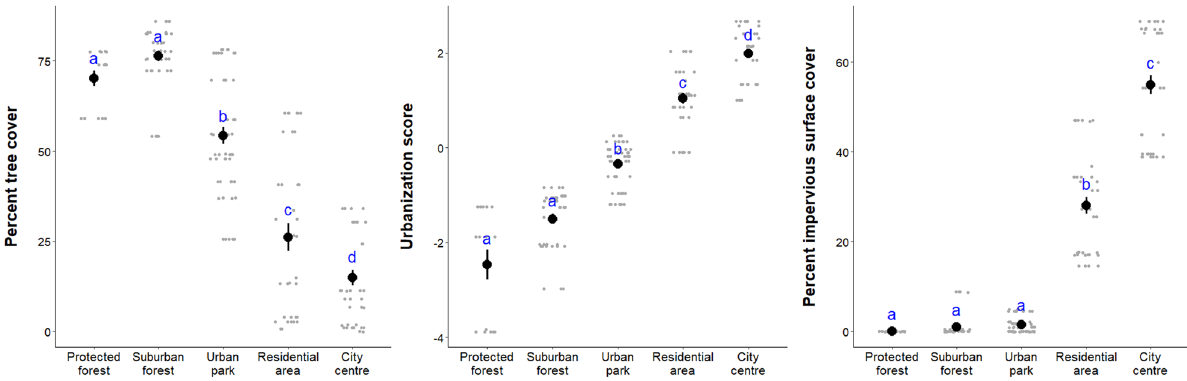
Figure 2. Mean ± se urbanization level, either percent tree cover, percent impervious surface cover or urbanization score (i.e. computed from imperviousness, tree cover, distance to the closest road and distance to the city centre) per habitat category. Significant differences of urbanization level between habitats are indicated by different